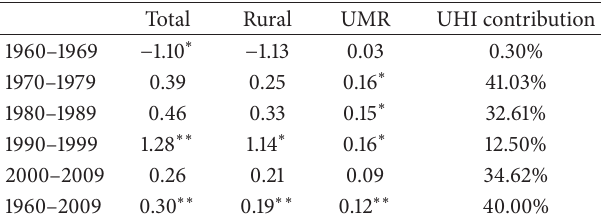
Table 4: Linear trends of regional average annual, rural, and UMR temperature ( ∘ Cdecade − 1 ) and the contribution of urban warming to the total warming for different time periods. Statistical signifi- cance is 0.05 (single asterisk) and 0.01 (double